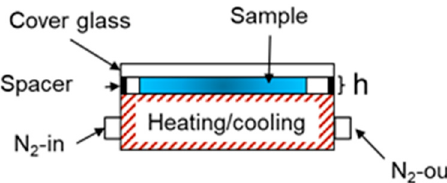
Figure 1. Vertical cut of the heating / cooling unit inside the freeze-drying microscope. Figure 1 . Vertical cut of the heating/cooling unit inside the freeze-drying microscope .